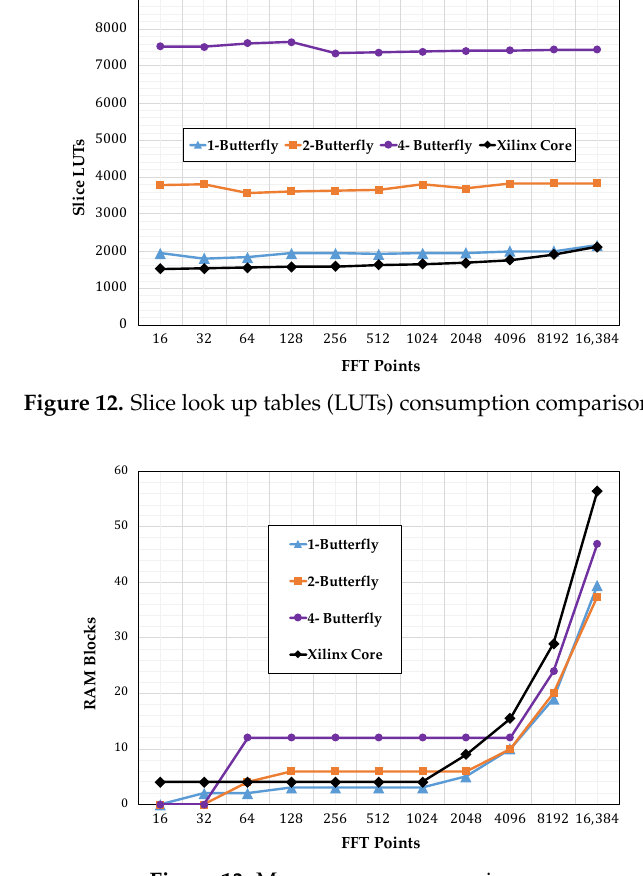
Figure 13. Memory usage